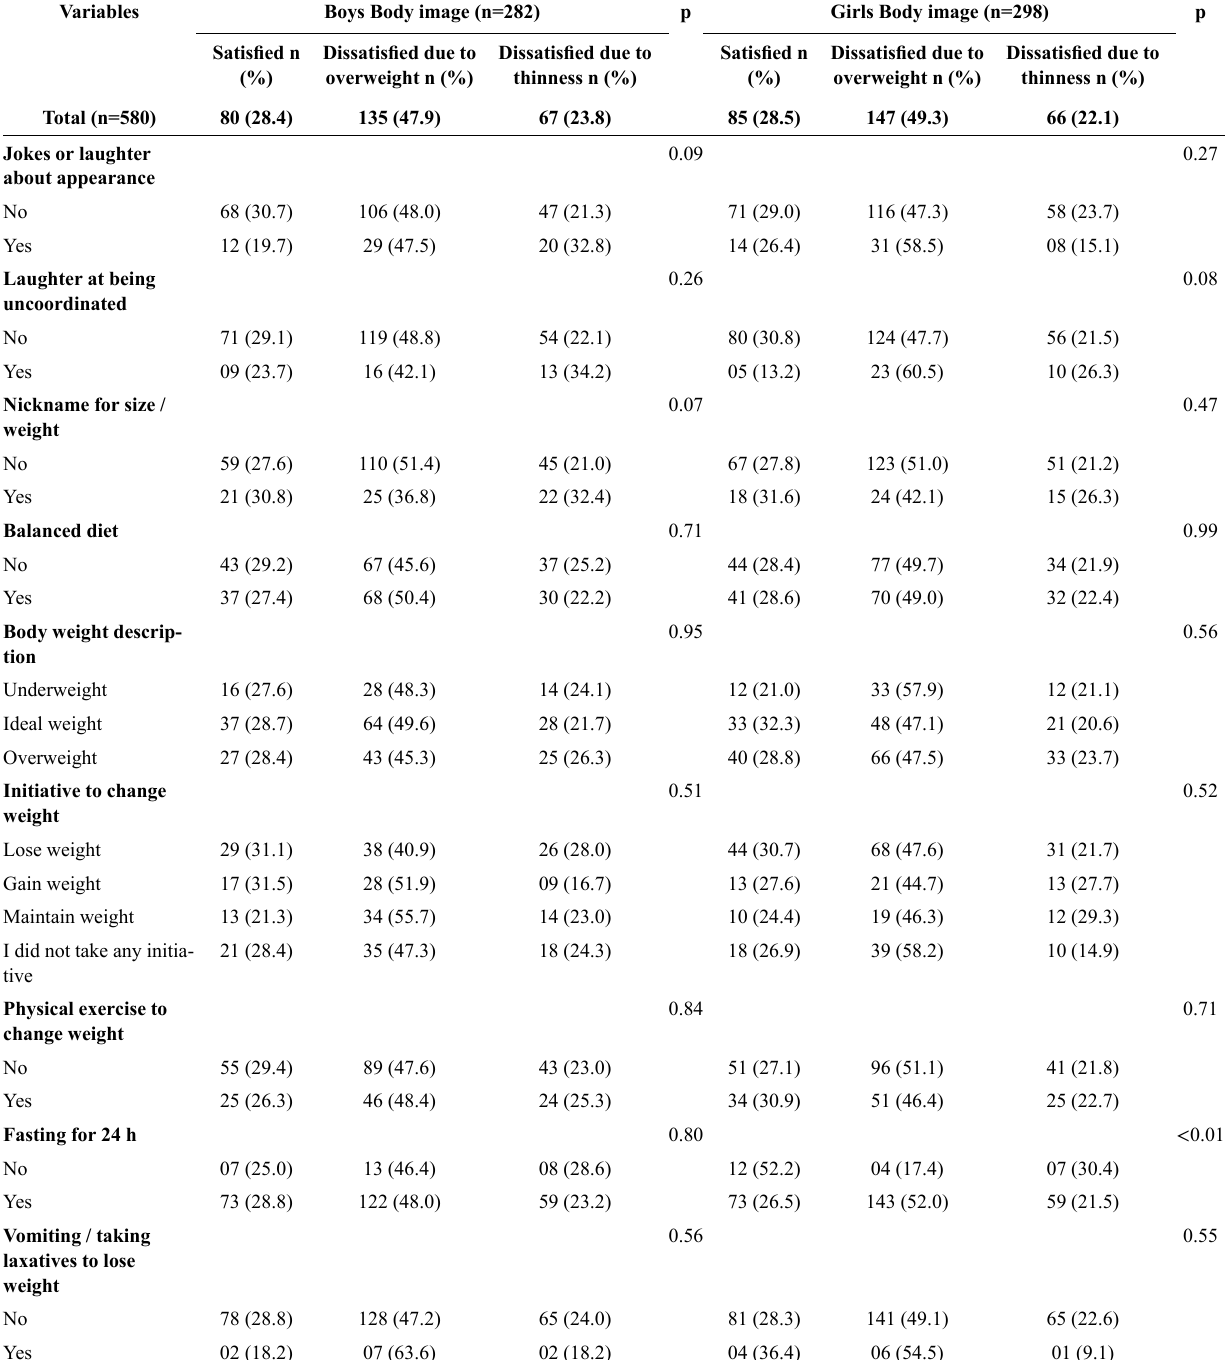
Table 1 - Sample distribution according to body image, stratified by sex, of adolescents enrolled in schools in the municipality of Criciúma, Santa Cata- rina, Brazil.